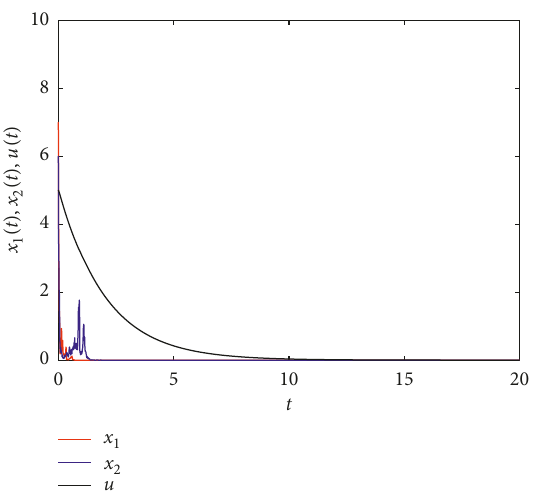
Figure 2: Time series diagram of ( x